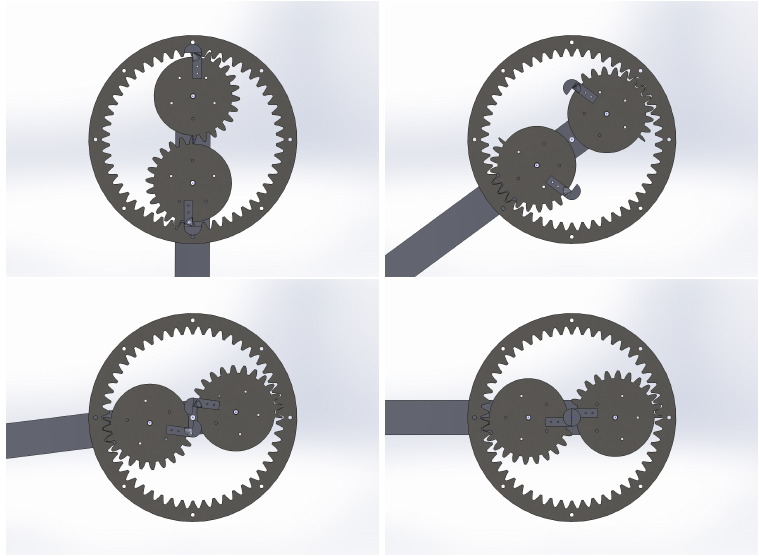
Figure 5. The hypocycloid gearing mechanism used to move the supports in a straight line along the leaf spring.